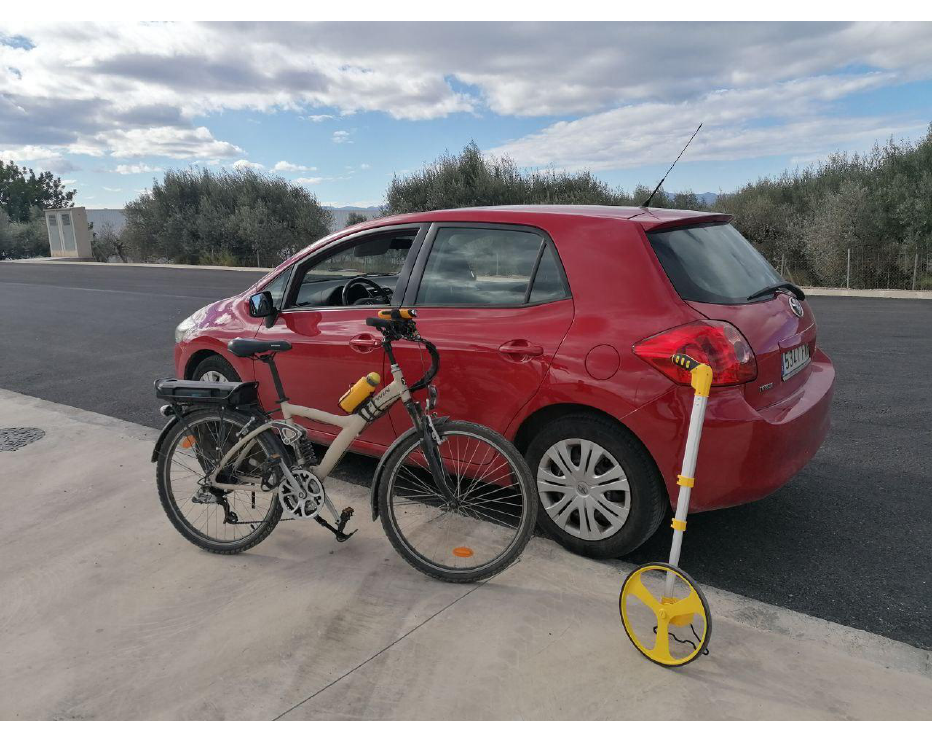
Figure 16. The car, the ebike, and the topometer used in the validation